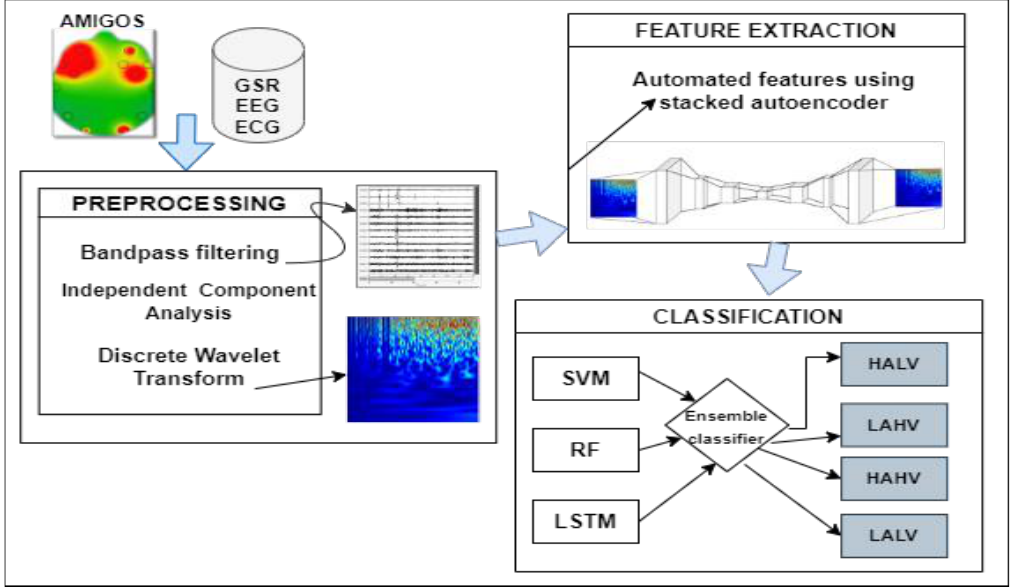
Figure 2. Block diagram of proposed method for emotion charting using multimodal signals.